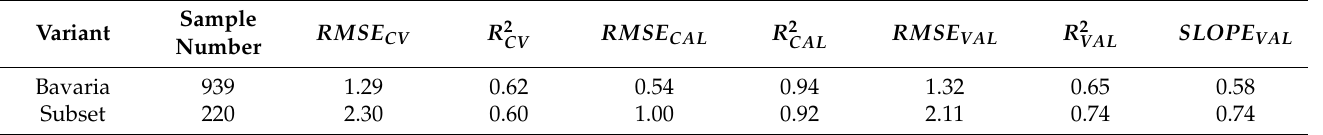
Table 2. Accuracy metrics for the SOC content (%) prediction based on SCMaP-SRC